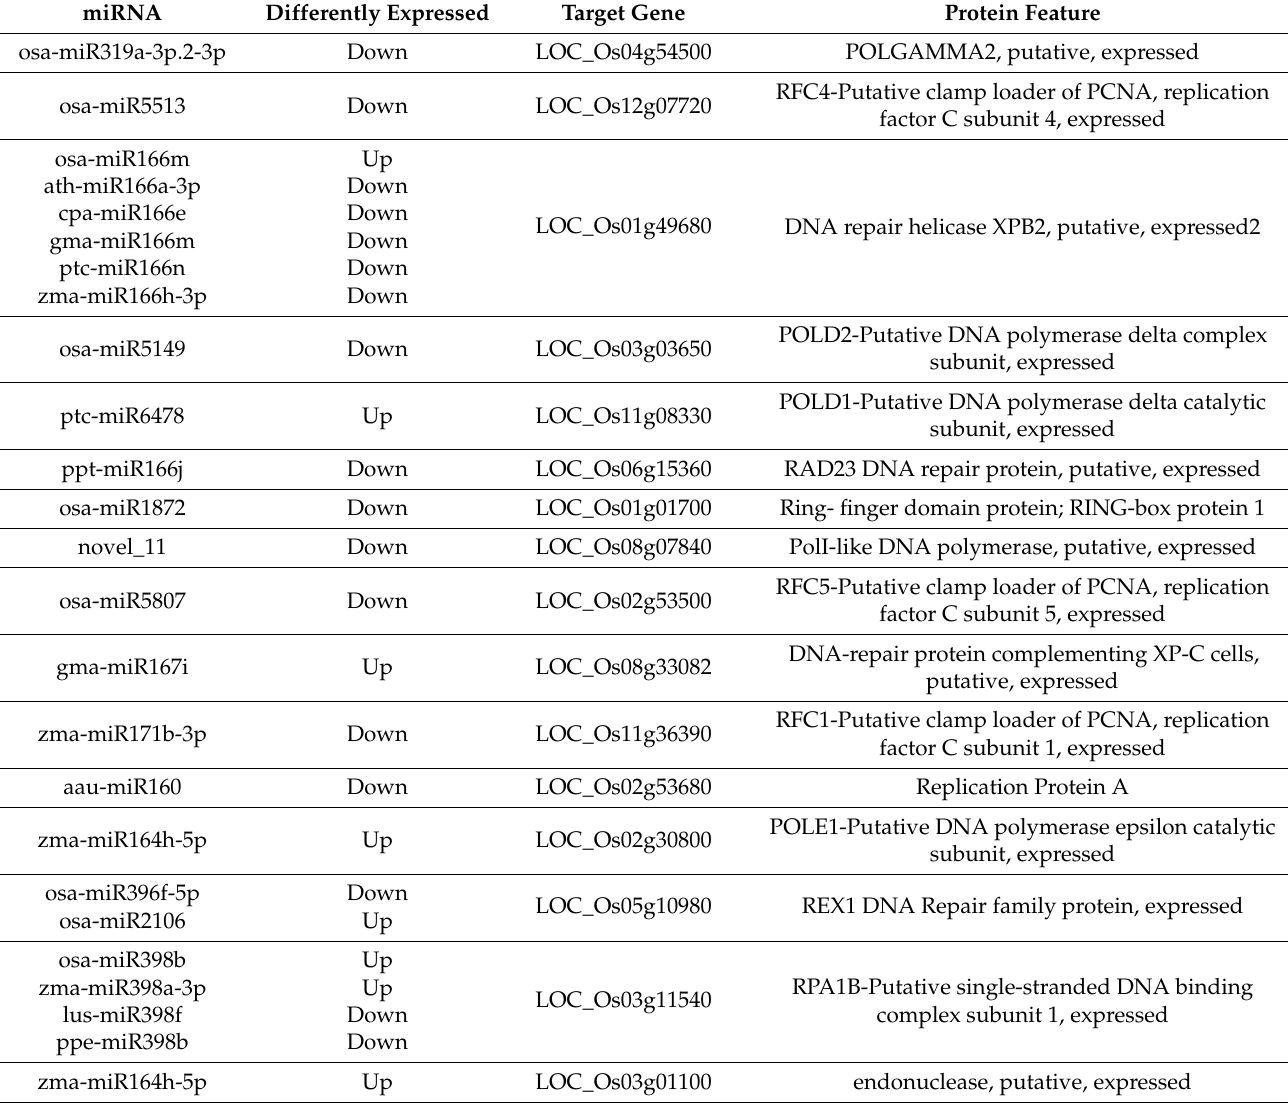
Table 4. List of differentially expressed miRNAs and target genes relating to DNA repair identified by KEGG pathway analysis.